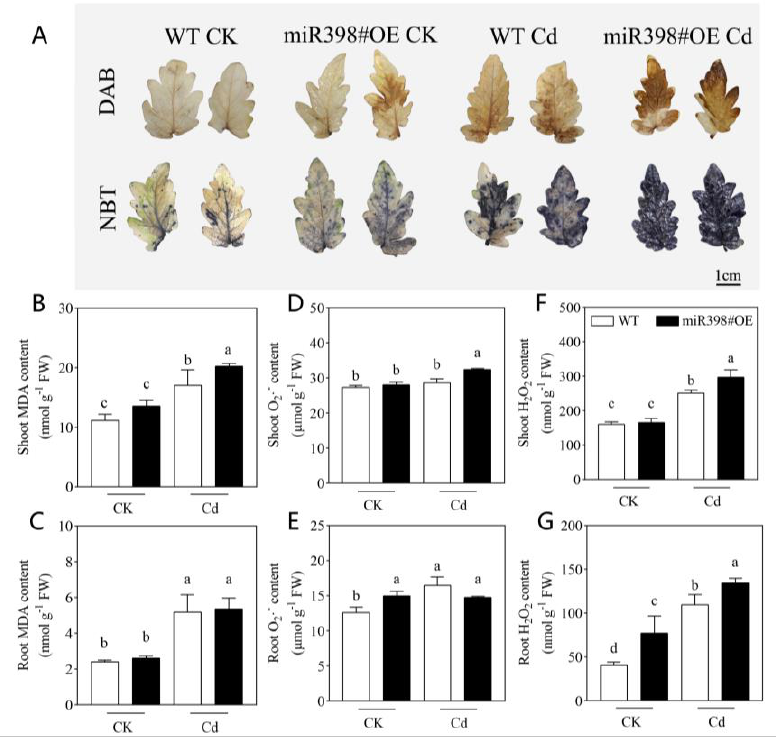
Figure 3. Cadmium stress-induced oxidative damage in wild type (WT) and transgenic line overexpressing MIR398 (miR398#OE). Superoxide anion (O 2 − ) and H 2 O 2 visualization using nitroblue tetrazolium (NBT) and diaminobenzidine (DAB) staining ( A ), malonaldehyde (MDA) content in the shoot ( B ) and root ( C ), O 2 − content in the shoot ( D ) and root ( E ), and H 2 O 2 content in the shoot ( F ) and root ( G ). Tomato seedlings (25 d old) of WT and miR398#OE were grown under control (CK) and 100 μM Cd(NO 3 ) 2 (Cd) for 9 d. The data are the mean values + SD of four individual replicates and different letters indicate significant differences ( p < 0.05). FW, fresh weight. Table 1. Effects of cadmium stress on the activities of antioxidant enzymes in tomato shoot and root of wild type (WT) and transgenic line overexpressing MIR398